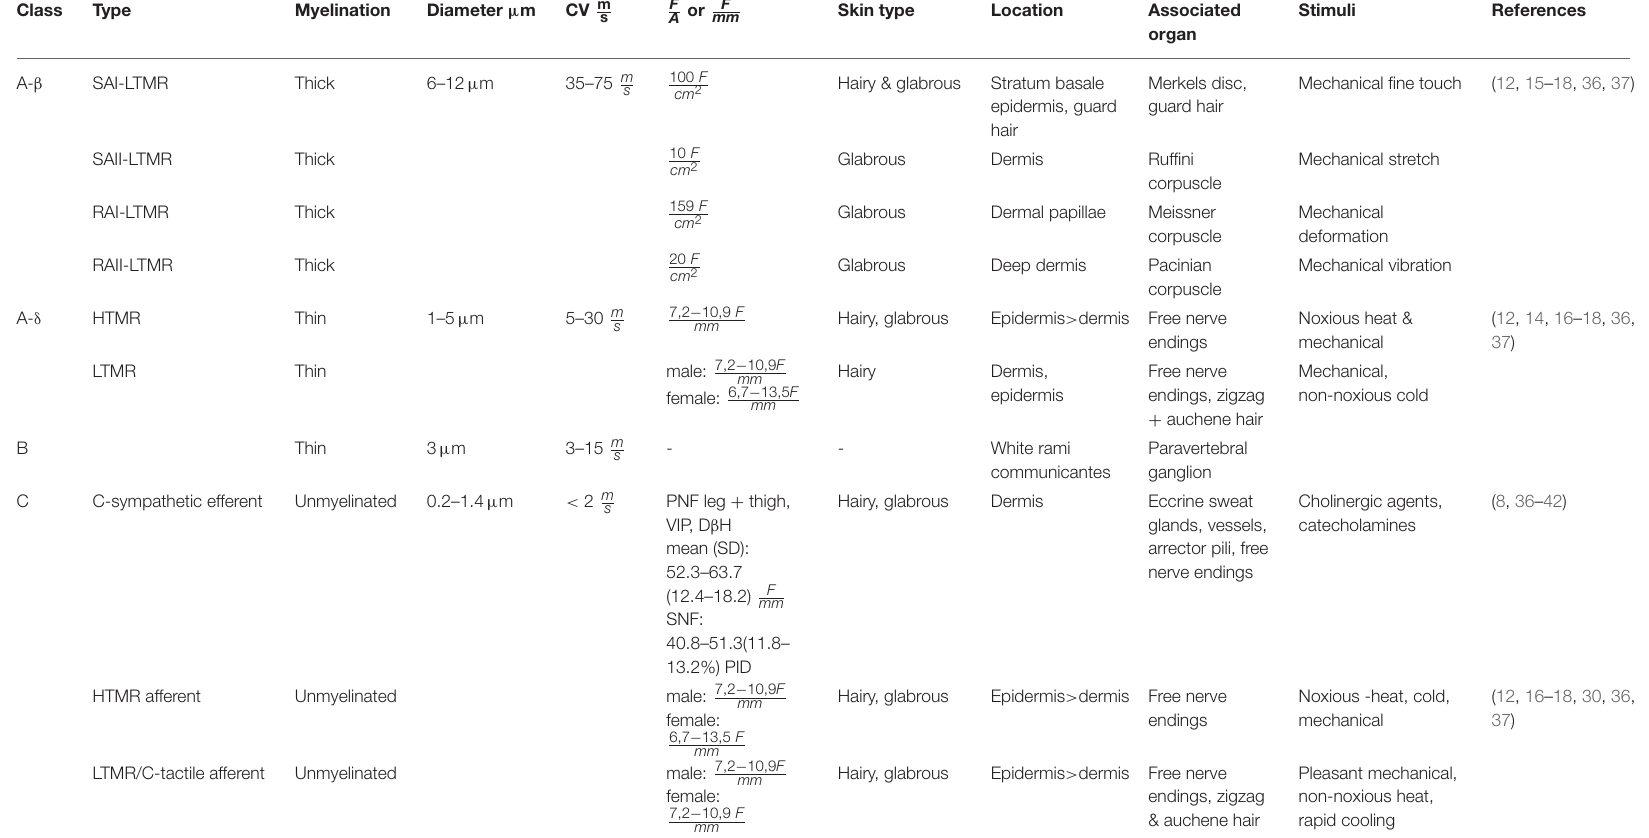
Table summarizing physiological and anatomical characteristics of different types of nerve fibers. SA, Slow Adapting; RA, Rapid Adapting; LTMR, Low Threshold Mechanoreceptors; HTMR, High Threshold Mechanoreceptors; CV, Conduction Velocity; F, Fiber; A, Area; PNF, Pilomotor Nerve Fiber; VIP, Vasoactive Intestinal Peptide; D β H, Dopamine beta Hydroxylase; SNF, Sudomotor Nerve Fiber; PID, Percent Intercept